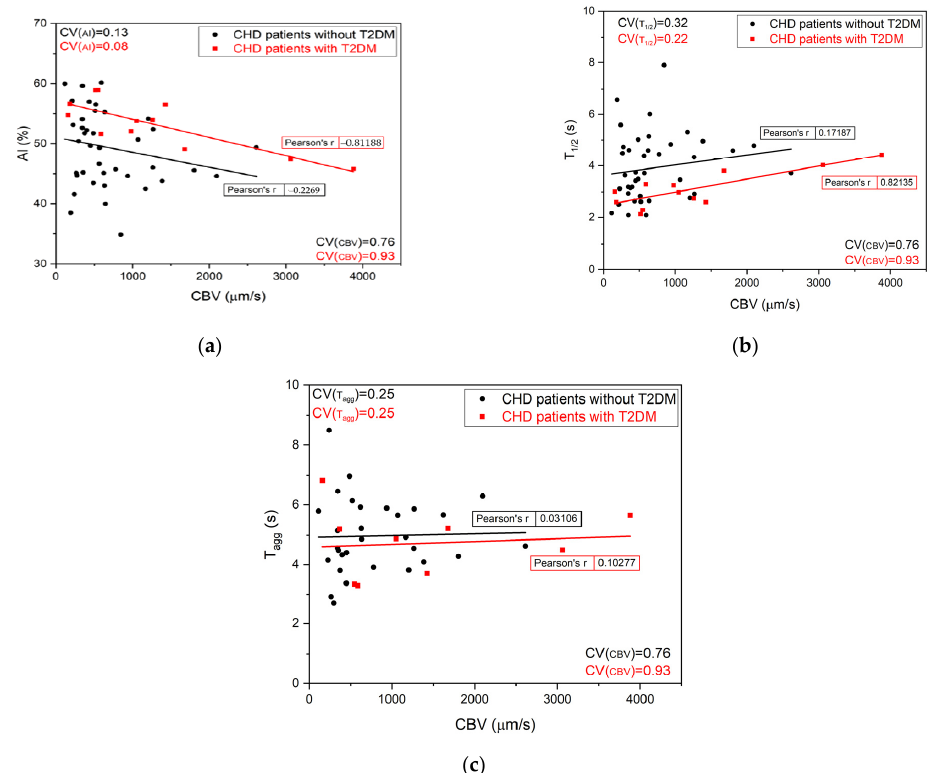
Figure 3. The individual values of AI ( a ), T 1/2 ( b ), and T agg ( c ) for groups of patients with and without T2DM versus the CBV. The linear fit and the Pearson’s r coefficient are shown. CHD—coronary heart disease; T2DM—type 2 diabetes mellitus; CBV—capillary blood velocity.